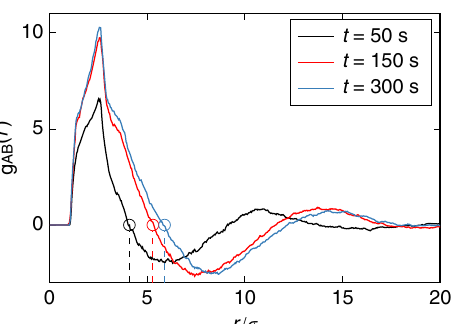
Fig. 9 Relative radial distribution function. Radial dependence of g AB ( r ) at times t = 50 s, 150 s and 300 s. The fi rst non-trivial root (marked by circles) is a quanti fi er for the characteristic domain size. The distance r is given in units of the particle diameter